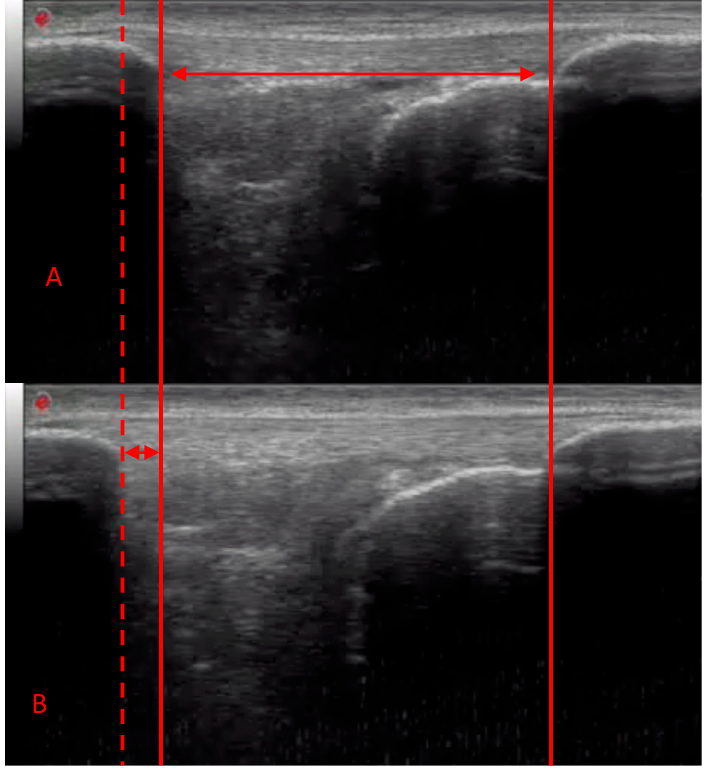
Figure 1. Ultrasonography images of the patellar tendon obtained at rest ( A ) and during a maximal isometric ramped contraction ( B ). The solid lines demonstrate the resting tendon length as measured between the apex of the patella and the tibial tuberosity. The dashed line represents the elongation of the tendon that has occurred during contraction.